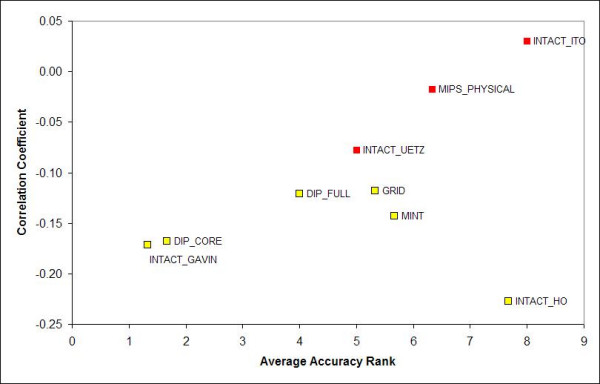
Error Rates in dataset. The Spearman's rank correlation coefficient, obtained using M musculus orthologs, is shown against a consensus measure for error rates. The consensus measure is calculated by averaging the rank of datasets for the three measures of error. Correlation coefficients marked in yellow indicate significant correlations, and the red markers indicate low statistical significance (Figure 2). Datasets that demonstrate stronger correlations between connectivity and evolutionary rate are more accurate whereas datasets that show no correlation are found to be less accurate. The notable exception here is the INTACT_HO dataset, and this may arise from experimental bias.